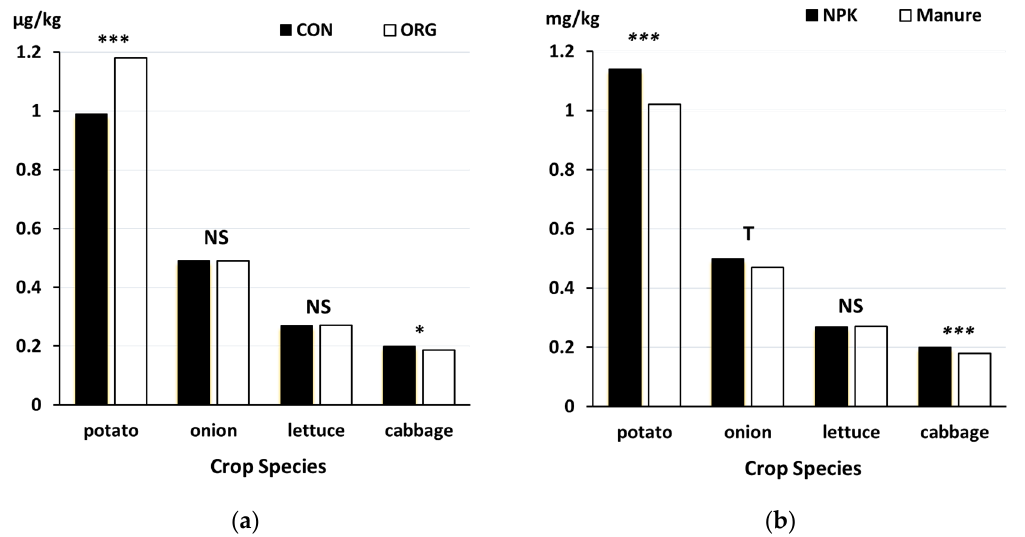
Figure 6. Effect of contrasting ( a ) crop protection (CON, conventional crop protection based on synthetic chemical herbicides, fungicides and insecticides; ORG, organic crop protection based on mechanical weed control and hand weeding and the use of Cu-fungicides in potato only) and ( b ) fertilization regime (mineral NPK versus manure applied at the same total N-input rate of 170 kg N hectare) used in organic and conventional farming on copper concentrations in potato tubers, onions, cabbage heads and lettuce leaves, Data from [58]. Bars represent main effect means of data from four growing seasons. ***, significant difference ( p < 0.001); *, significant difference ( p < 0.05); T, trend (0.01 < p < 0.05); NS, not significant.